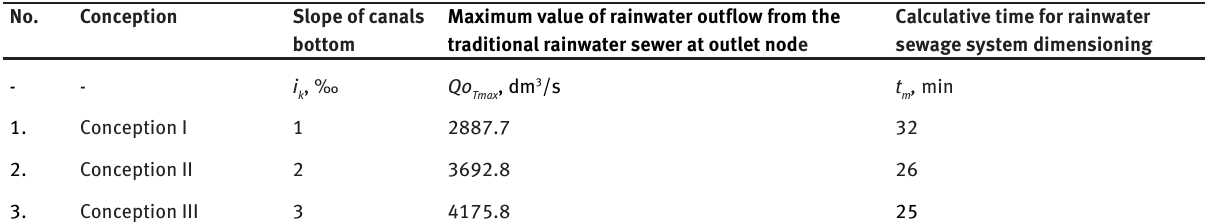
The traditional rainwater sewage system No.